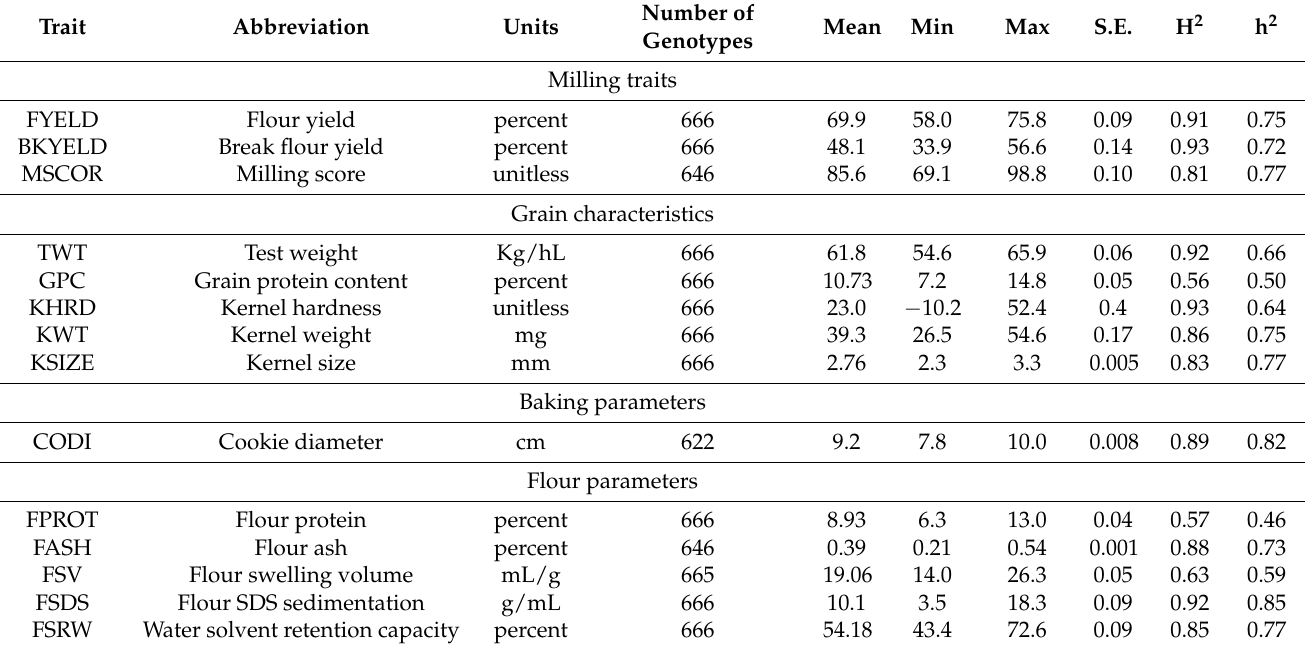
Table 2. Summary of the fourteen end-use quality traits evaluated for genomic selection analysis using nine different prediction